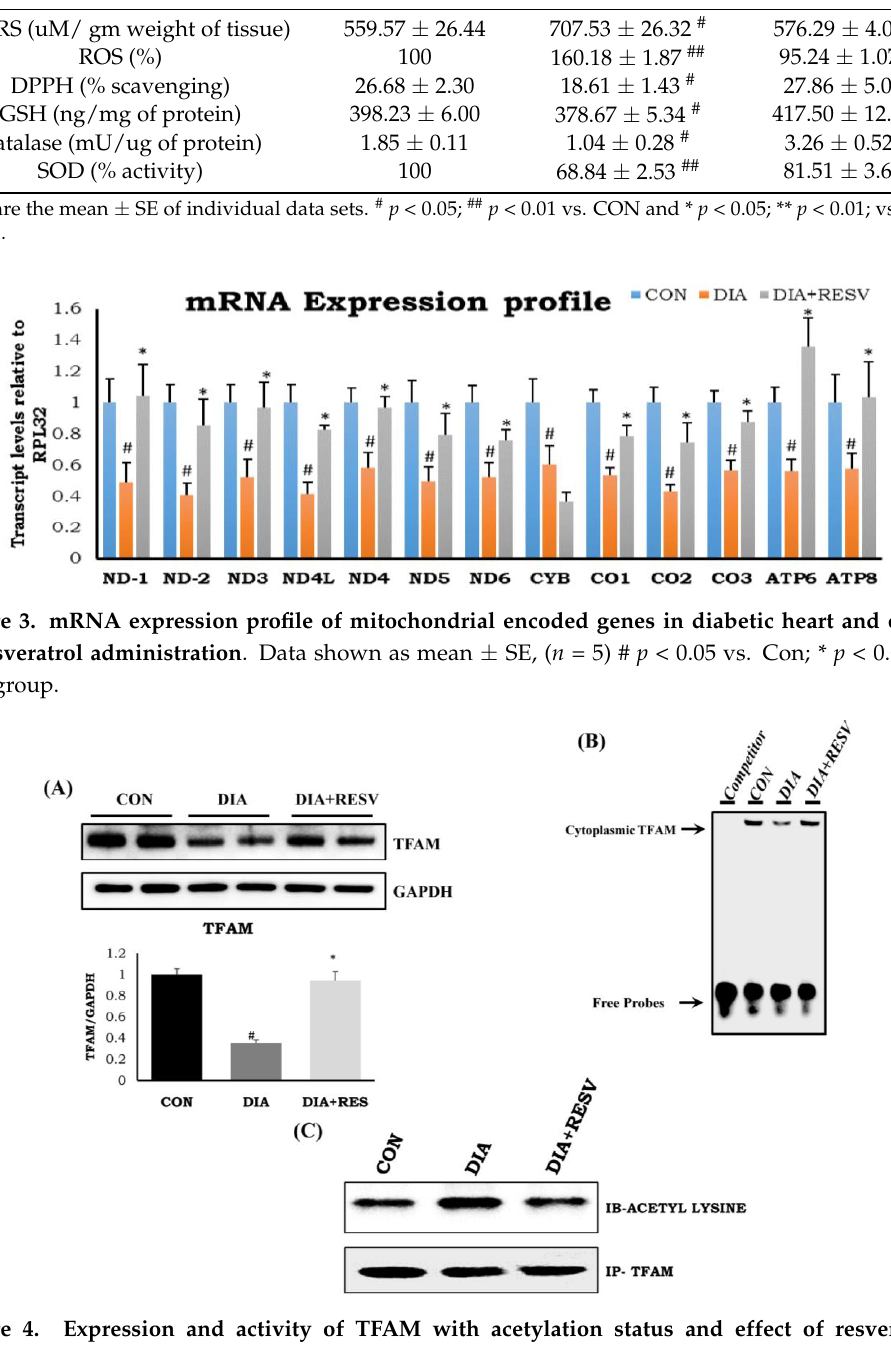
Figure 4. Expression and activity of TFAM with acetylation status and effect of resveratrol administration . ( A ) Protein expression of TFAM; ( B ) Activity of TFAM by electrophoretic mobility administration . ( A ) Protein expression of TFAM. ( B ) Activity of TFAM by electrophoretic mobility shift assay (EMSA) assay; ( C ) Acetylation status of TFAM. Data shown as mean ± SE, ( n = 4) # p < 0.05 shift assay (EMSA) assay. ( C ) Acetylation status of TFAM. Data shown as mean ± SE, (N = 4) # p < 0.05 vs. Con; * p < 0.05 vs. DIA vs. Con; * p < 0.05 vs. DIA group.